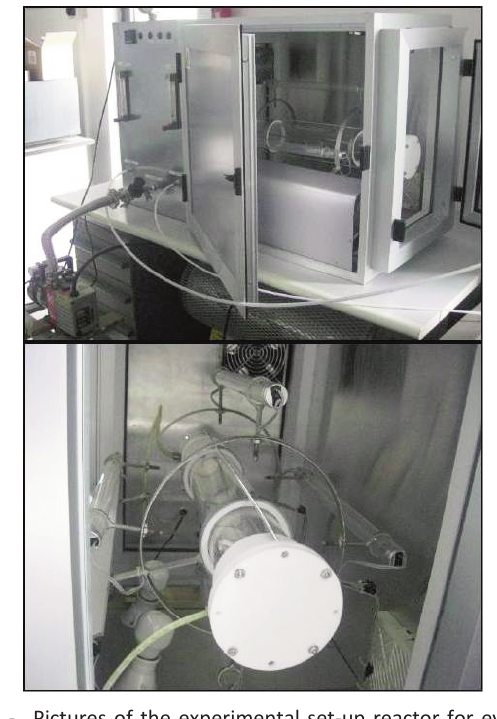
Fig. 1 - Pictures of the experimental set-up reactor for evaluat- ing photocatalysis efficiency. Fig. 2 - Pore size distribution curve of (A) the mesoporous silica (SBA) and (B) TiO 2 (TSBA-10).